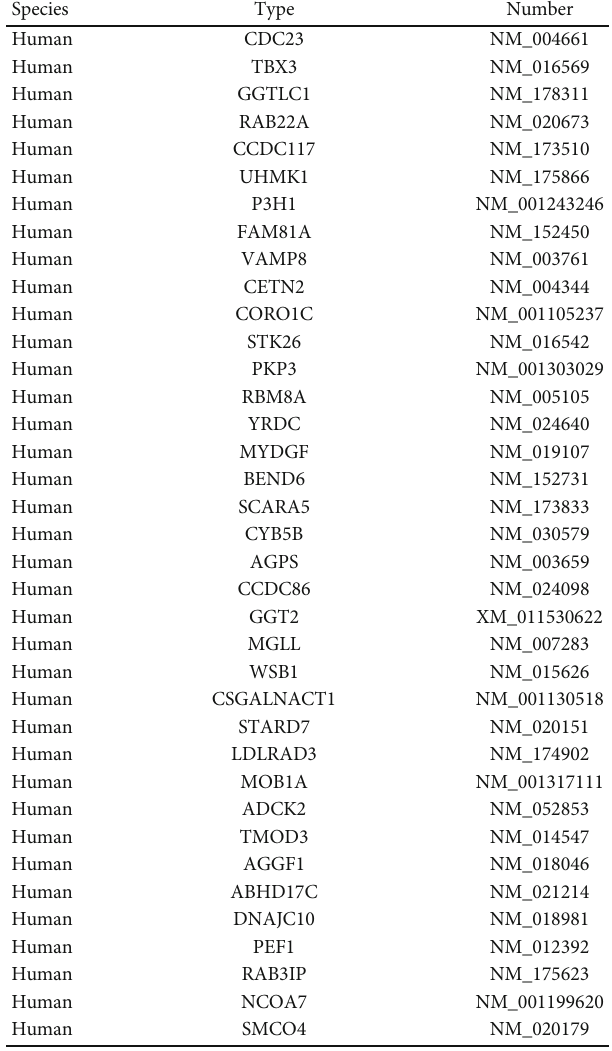
Table 1: Downstream candidate genes of